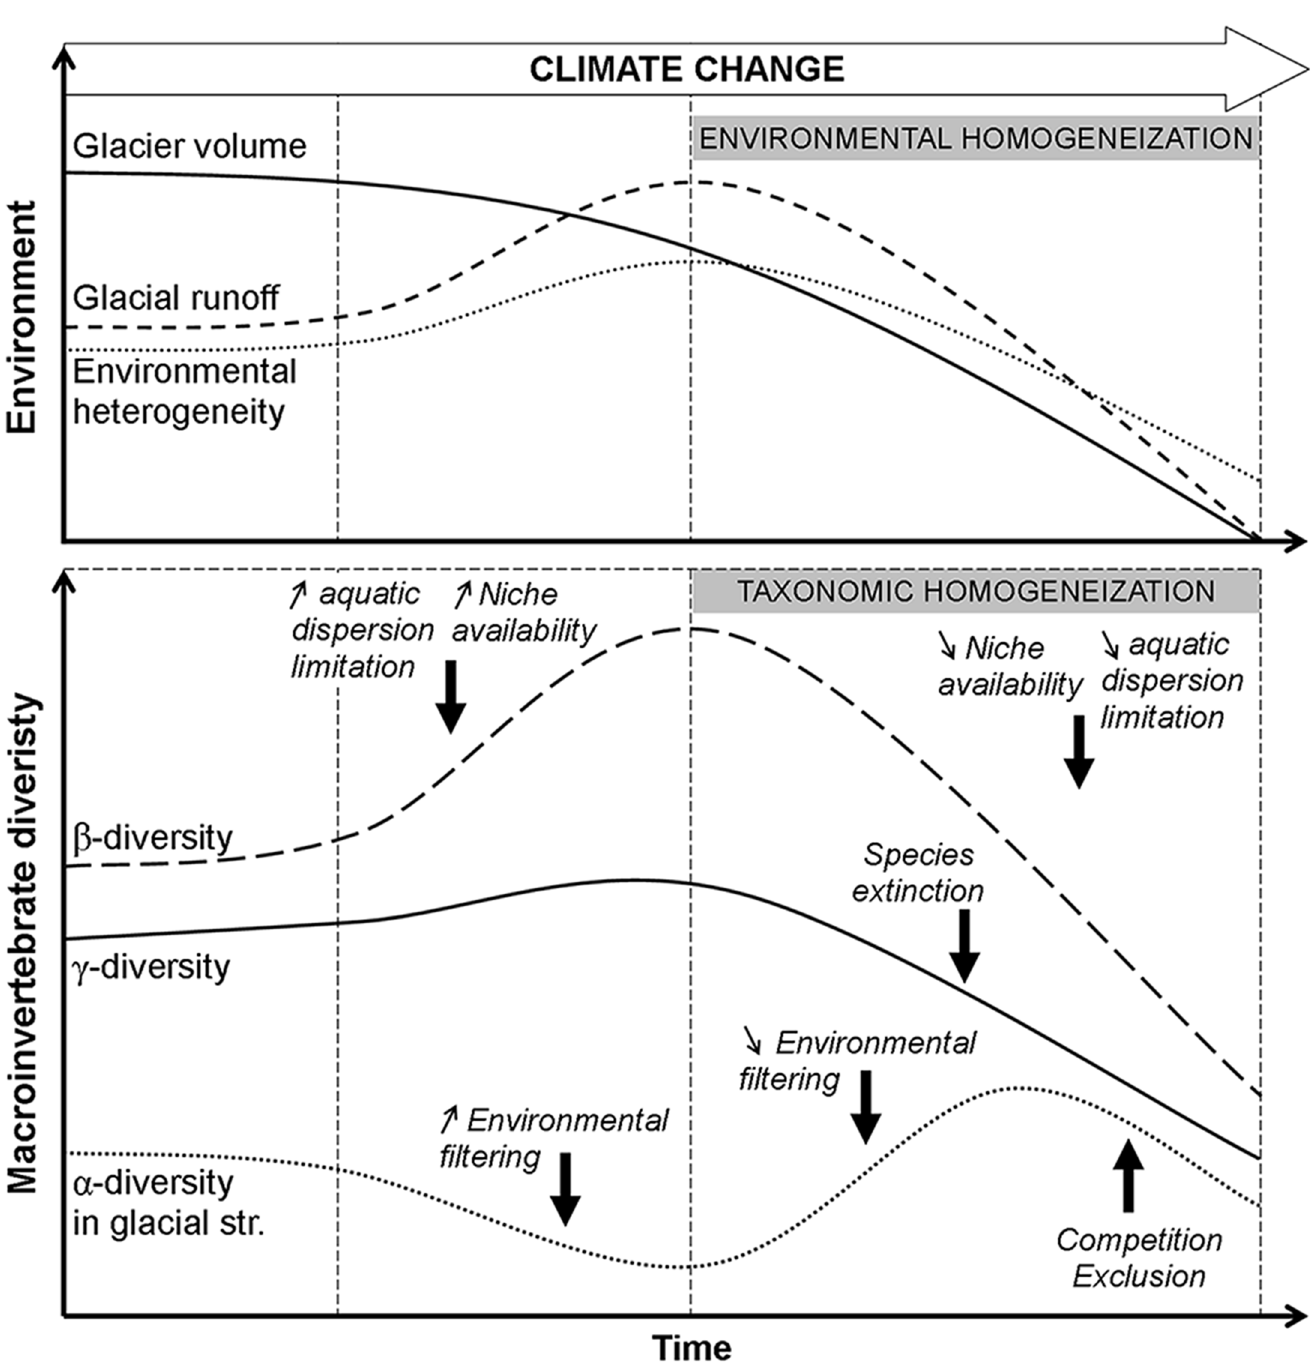
Fig 4. Conceptual diagram illustrating expected temporal changes in alpine aquatic diversity under the ongoing climate change: α -diversity in glacier-fed streams, β -diversity, and γ -diversity in glacierized catchments according to alteration in glacial meltwater contribution to alpine streams flow. This conceptual diagram was built based on the mechanisms structuring the aquatic macroinvertebrate metacommunity revealed in this study and those from the literature on the organization of α , β , and γ diversity. Species extinction included species in headwater streams (both glacier-fed and groundwater streams). Up arrow and down arrow symbols signified increase and decrease,